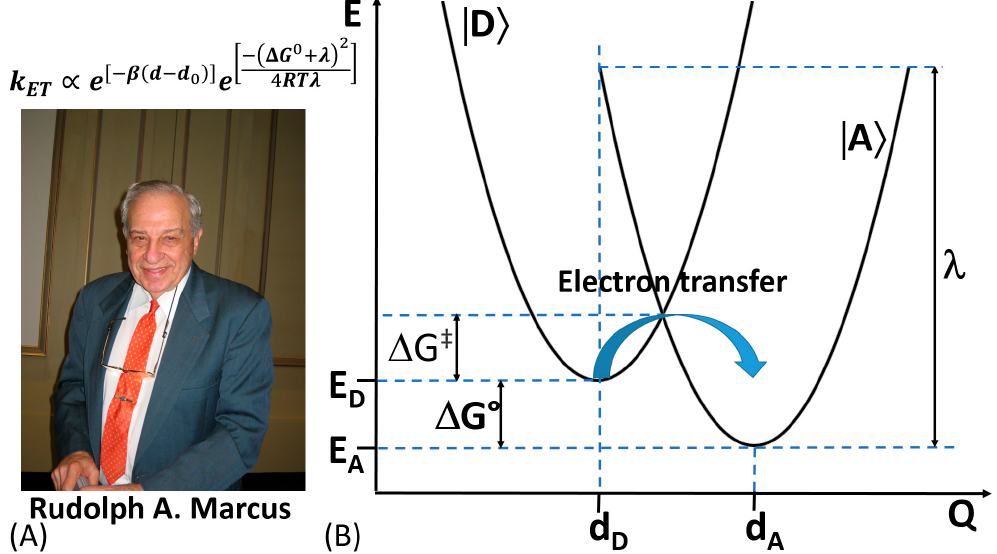
Figure 7. ( A ) Rudolph A. Marcus, the Nobel Prize in Chemistry (1992) recipient "for his contributions to the theory of electron transfer reactions in chemical systems." ( B ) Profile of potential energy (E) surfaces vs. nuclear coordinates (Q) for a reactant, an electron donor ( | D ), and a product, electron acceptor ( | A ), corresponding to an electron transfer reaction: d D and d A —coordinates corresponding to the energy minimum of the reactant and product, respectively; E D and E A minimum energies (redox potentials) of the reactant and product, respectively; ∆ G ◦ and ∆ G ‡ —free Gibbs energy change and activation energy, respectively, in the course of the electron transfer reaction; λ —reorganization energy upon transition from the reactant to the product. The equation is the theoretical expression derived by R. A. Marcus for the electron transfer reaction rate dependence on the energy parameters and electron transfer distance (see explanations for all parameters in [75]. (The photo is adopted from Wikipedia, public domain.).